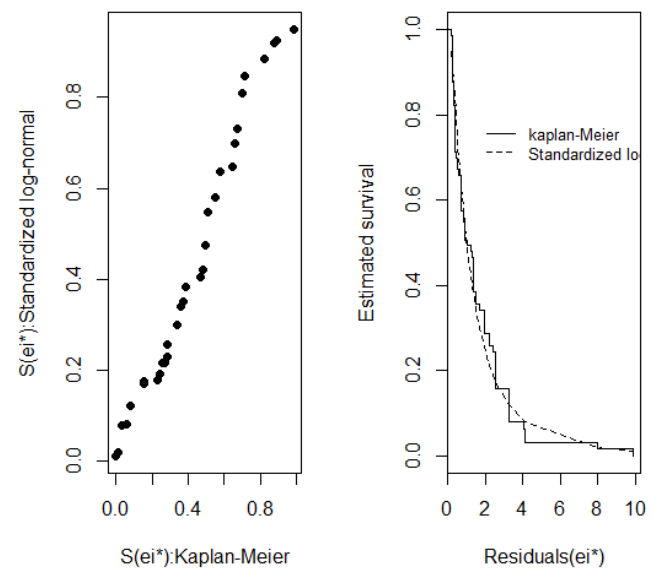
Figure 2. Standardized ê i * residuals evaluating the overall final model fit.